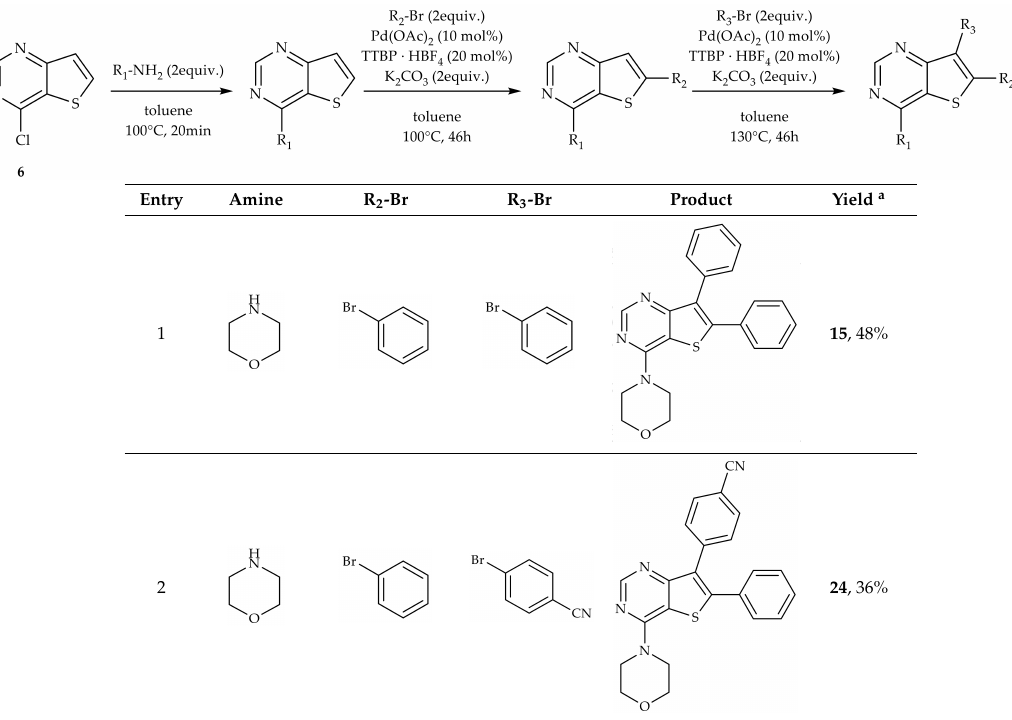
Table 6. One pot three-step selective SnAr, Pd-catalyzed C–H activation on the C-2 then on the C-3 positions of the thiophene moiety.